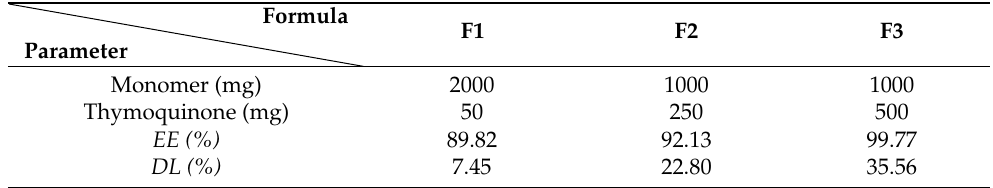
Table 5. TQ -loaded poly(ester amide) based on L-arginine nanoparticles, showing the composition, EE%, and DL%